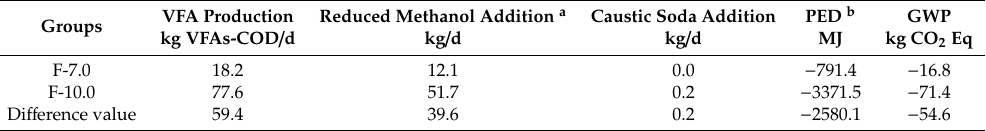
Table 3. Preliminary evaluation of the environmental benefits of FSF under alkaline condition.